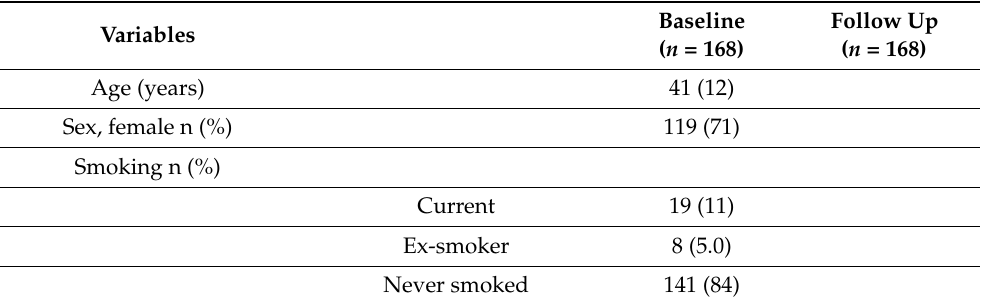
Table 1. Clinical and metabolic characteristics of the study population (mean (SD) unless otherwise